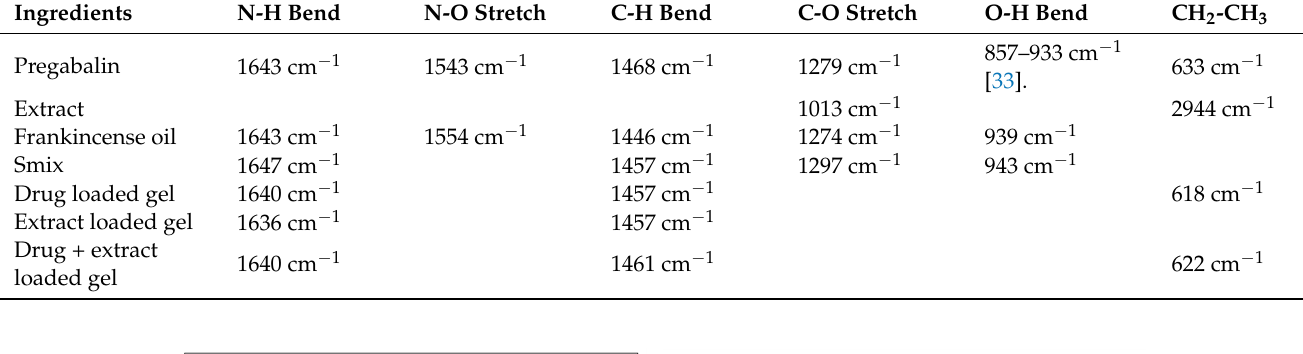
Table 1. Peaks showing bending stretching of different excipients and topical gels.